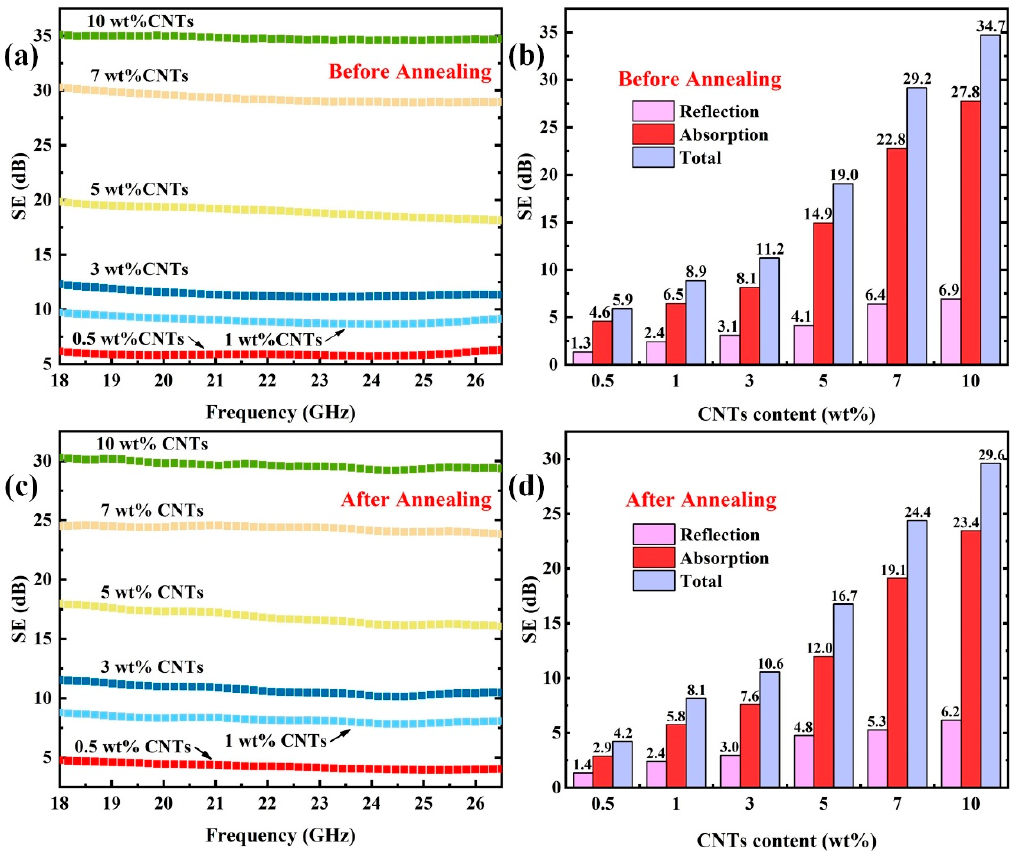
Figure 10. EMI shielding efficiency of PEEK/CNTs composites with different CNT contents in the range from 18 GHz to 26.5 GHz: ( a ) before annealing; ( c ) after annealing; the SE (SE T , SE A , SE R ) for the PEEK/CNTs composites at the frequency of 22 GHz: ( b ) before annealing; ( d ) after annealing.